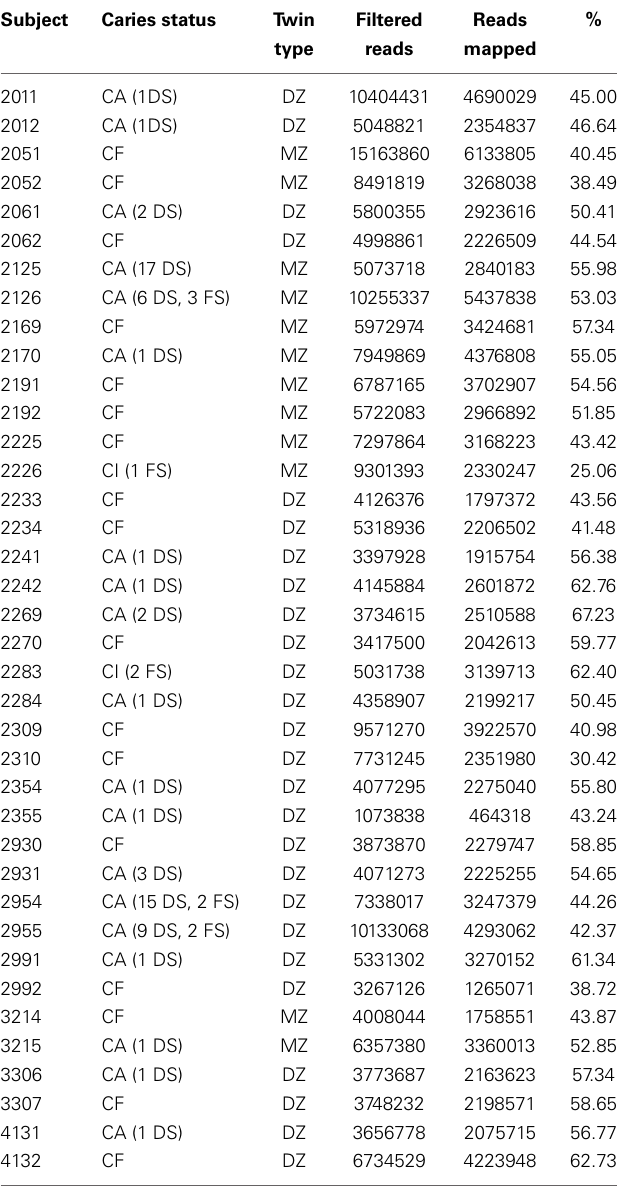
Table 1 | Human subjects and RNA-Seq